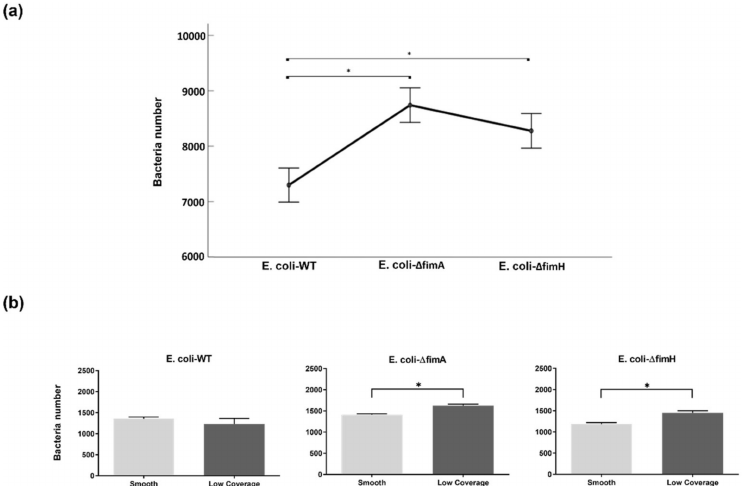
Figure 6. E ff ect of fimbriae on adhesion for all tested E. coli strains. ( a ) Bacteria number (calculated marginal means) significant at * p -value < 0.05. Median values with error bars represent the 95% confidence interval ( n = 191, * p < 0.05). ( b ) Comparison within tested strains between smooth and low coverage. Average bacteria number to di ff erent surface coverages with the standard error of the mean. Significant at * p -value < 0.05, n =